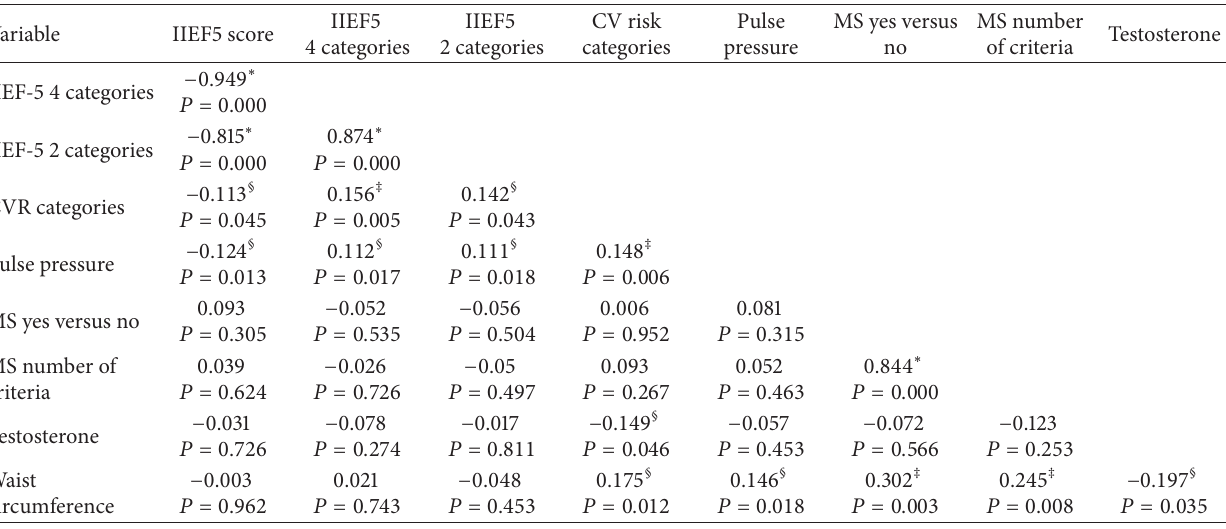
Table 2: Partial correlations adjusted for age and smoking.